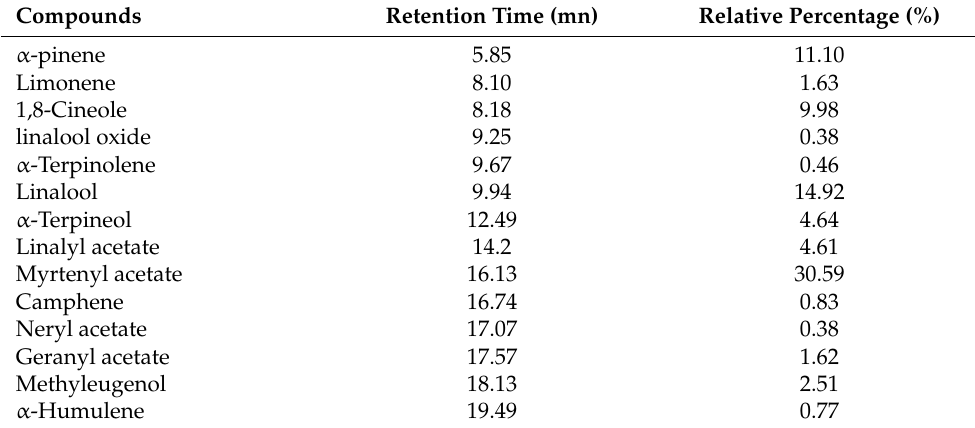
Table 1. Chemical composition of Myrtus communis essential